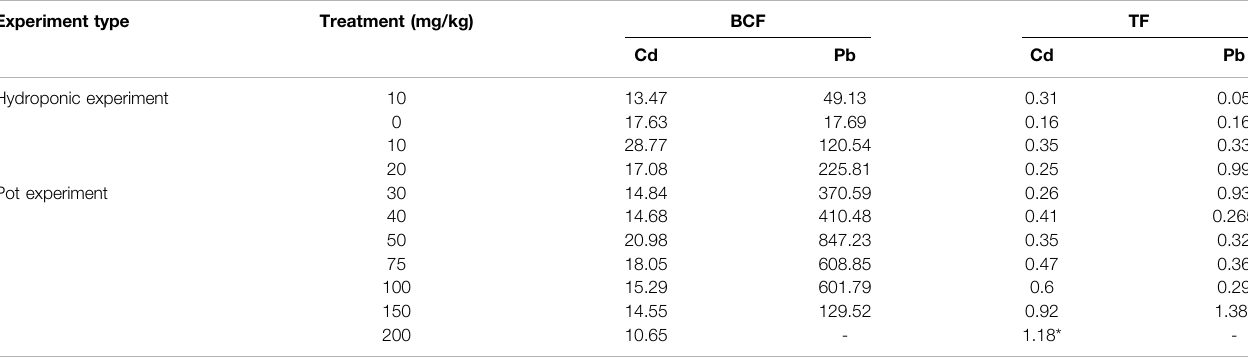
TABLE 1 | Bioconcentration factor (BCF) and translocation factor (TF) of Cleome rutidosperma for both the hydroponic and pot experiments against Cd and Pb. The values marked with (*) are greater than 1, showing positive translocation of heavy metal to the aerial parts of the plant. Experiment